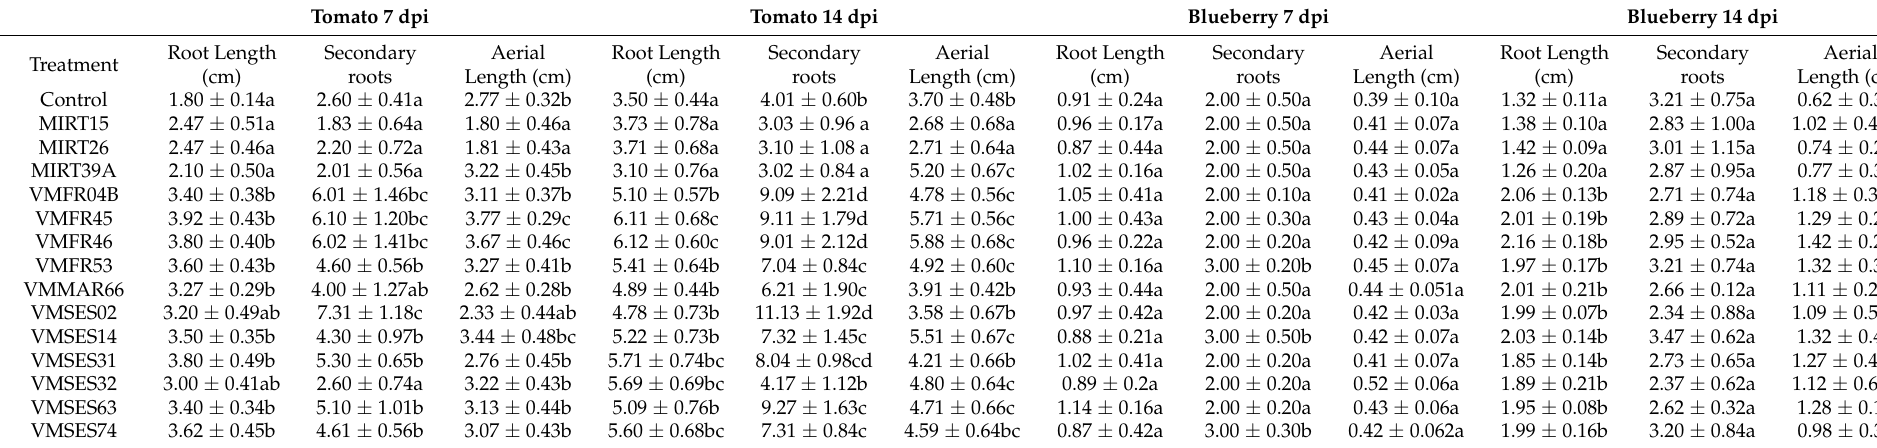
Table 2. Growth parameters of tomato and blueberry seedlings inoculated with the selected